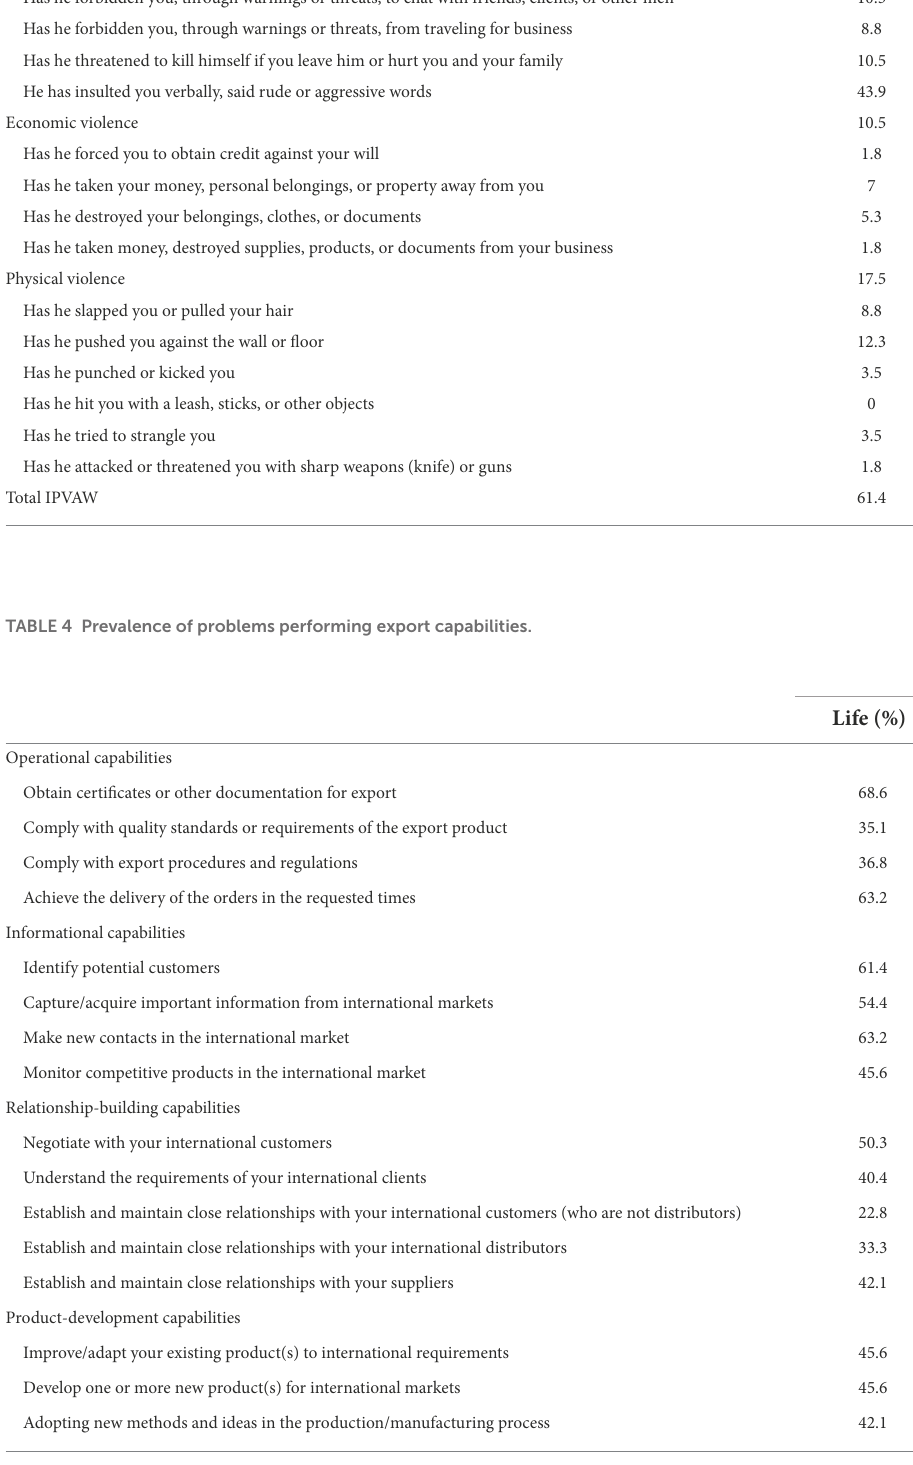
TABLE 3 Prevalence of women exporters who suffered IPVAW by their partner or former